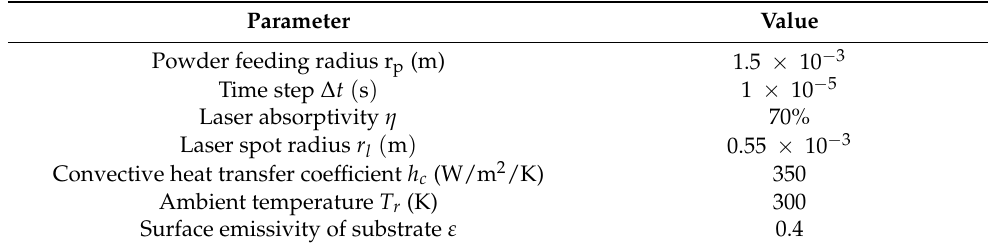
Table 1. Data used in the simulation.